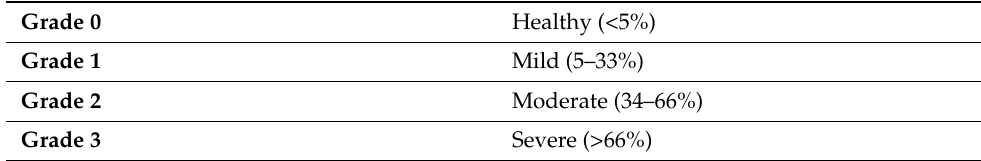
Table 1. Liver steatosis grades (S) according to histopathologic classification. Percentage (%) is related to the fat content within the